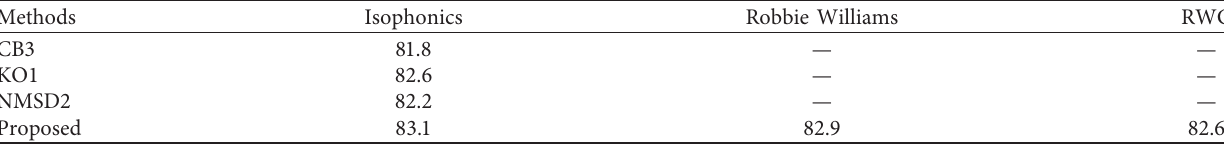
Table 2: Recall of major and minor chords accomplished by various algorithms including the weighted chord symbol. Methods